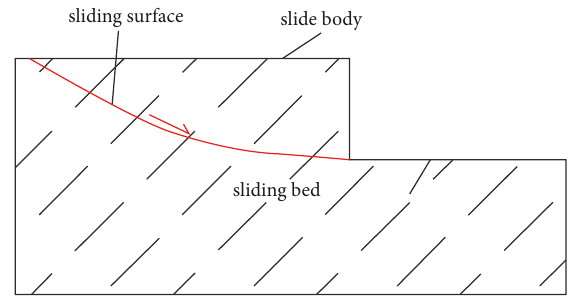
Figure 3: Schematic of a typical cross-section of ideal landslide (made by the